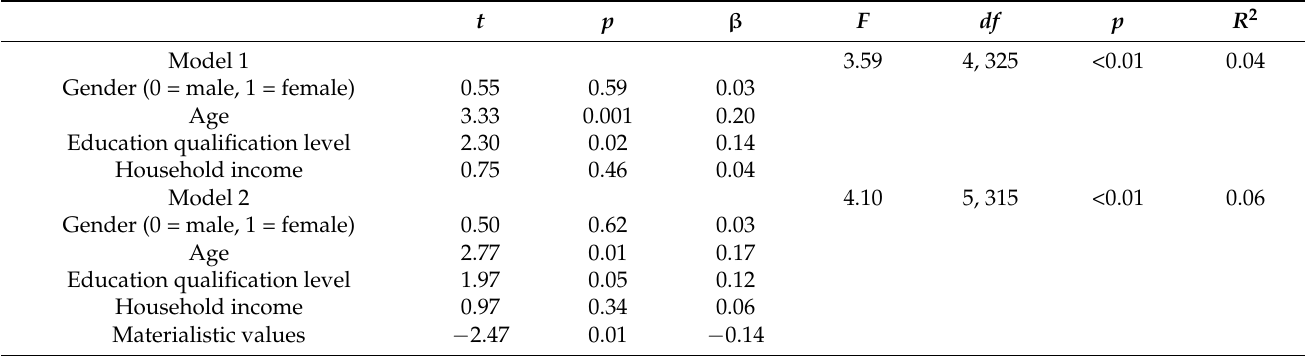
Table 3. Linear Regression Analysis examining the influence of the materialistic values on mindfulness.